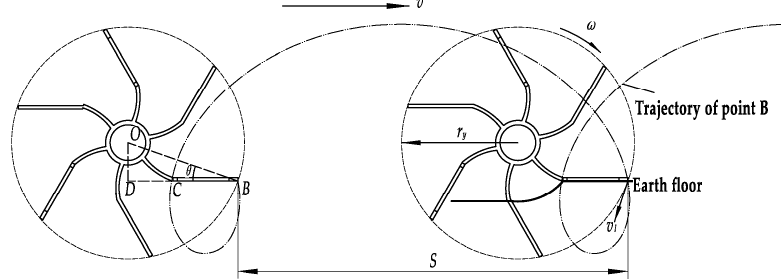
Figure 3. Motion analysis diagram of weeding wheel under ideal state.